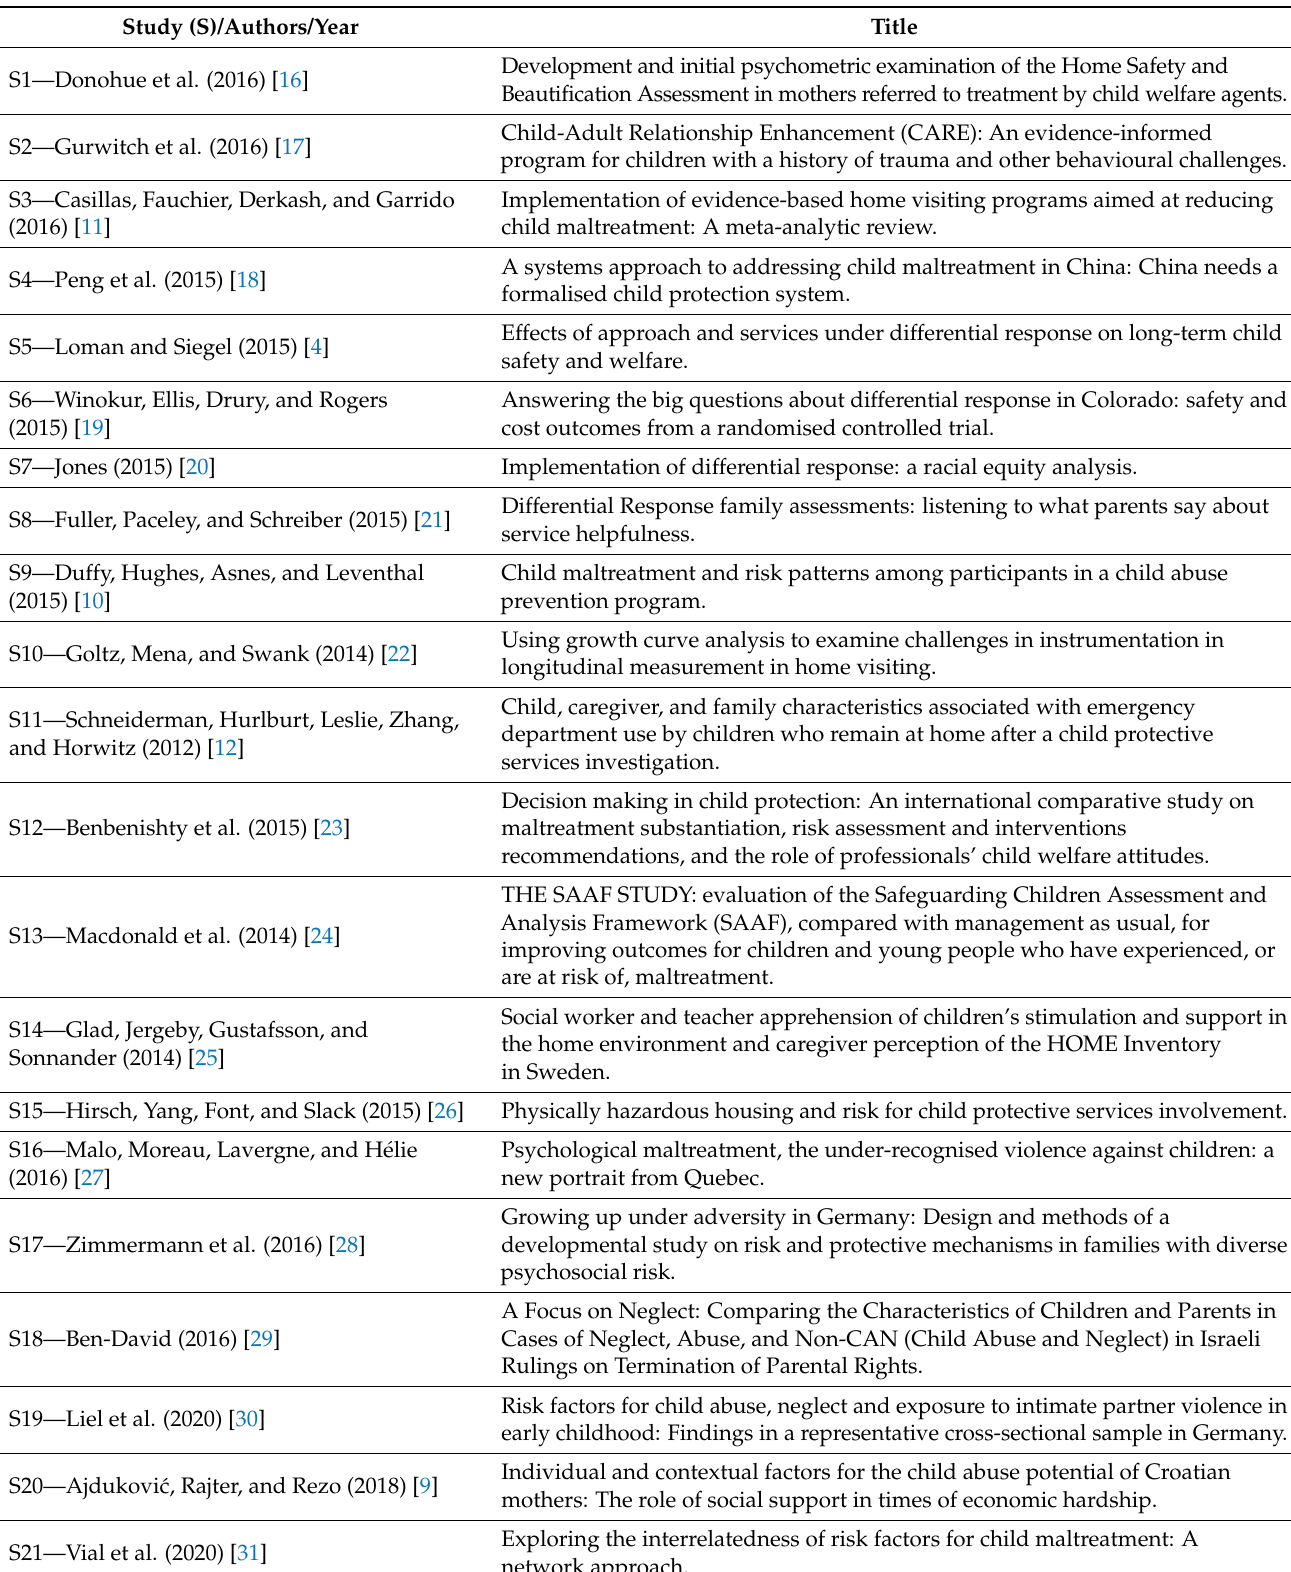
Table 1. Selected